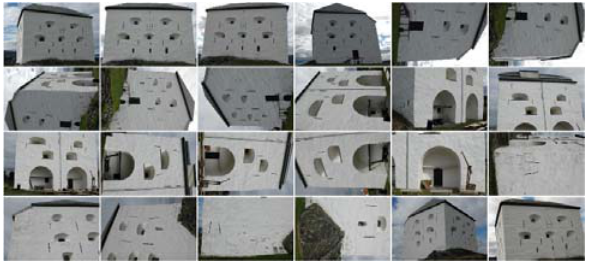
Figure 14. Overview of 24 photographs used for automatic texture mapping of the 3D building model of fortress